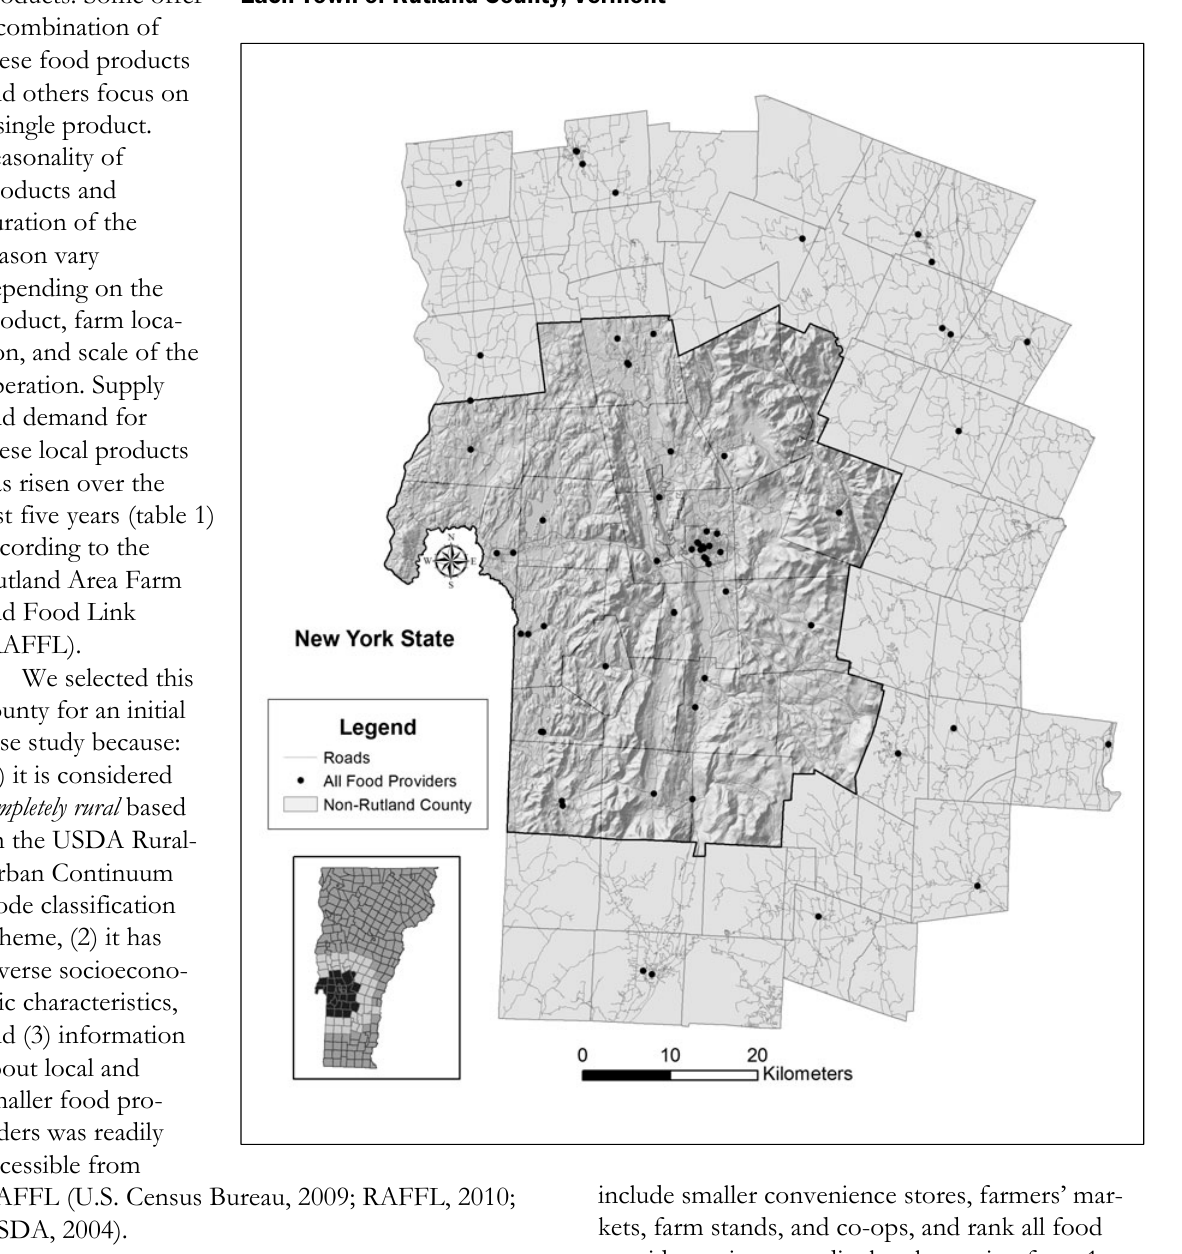
Figure 1. Location of Study Area Indicating the Location of Food Providers Within Each Town of Rutland County,